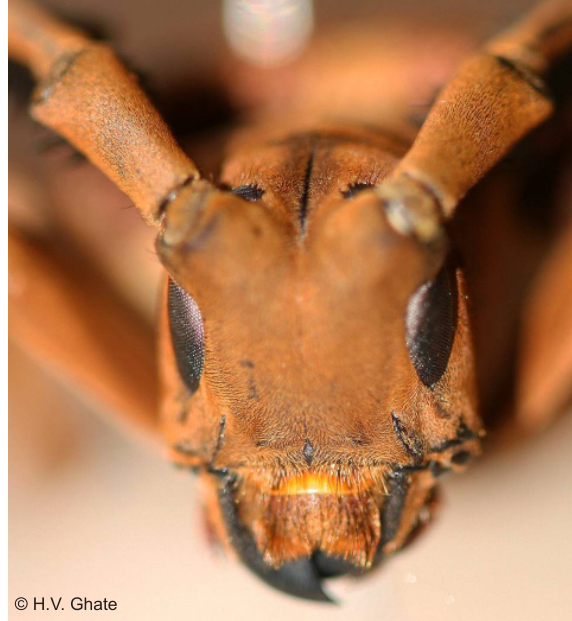
Image 4. Sarothrocera lowii White, frontal view of the head